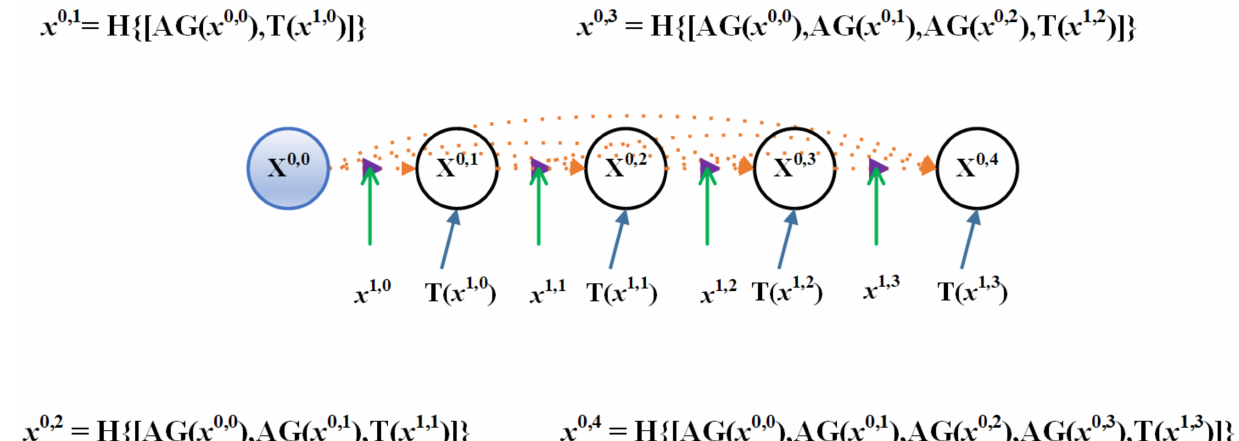
Figure 5. Detailed analysis of the first skip pathway of Residual-Attention